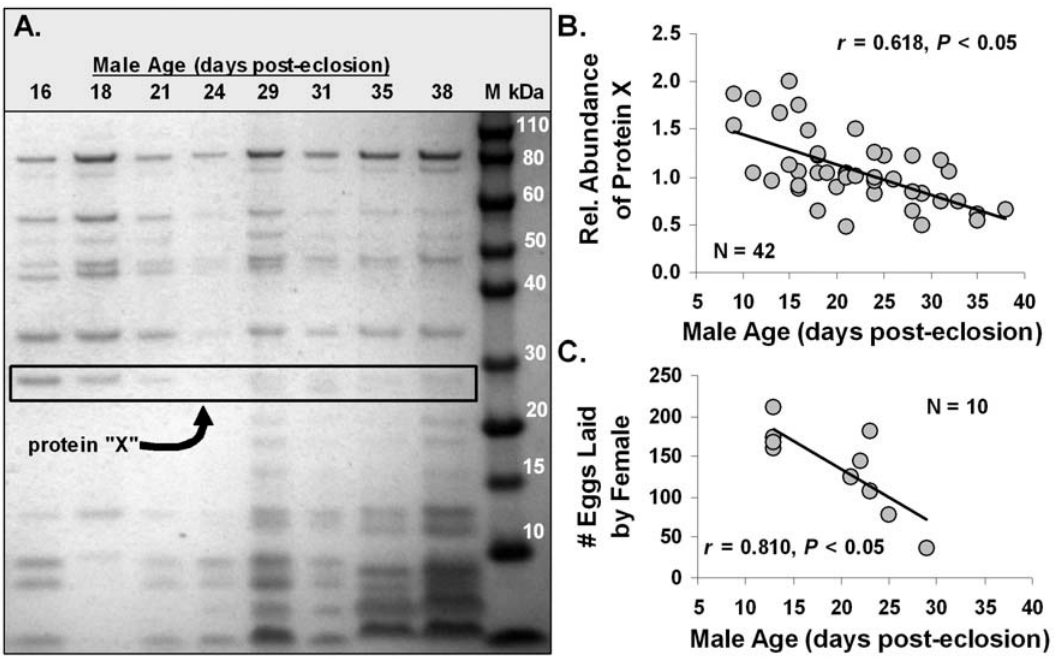
Figure 2. Protein ‘‘X’’ and the effects of male age. The decrease in abundance of protein ‘‘X’’ in a male’s ejaculate is associated with increased male age (A; each lane represents the protein from a single spermatophore), while (B) demonstrates the statistical significance of this relationship (each point represents the data from a single spermatophore). (C) The association between male age and a male’s ability to induce a female to lay eggs – suggesting that the relative abundance of protein ‘‘X’’ may be linked to a male’s ability to induce a female to lay eggs.